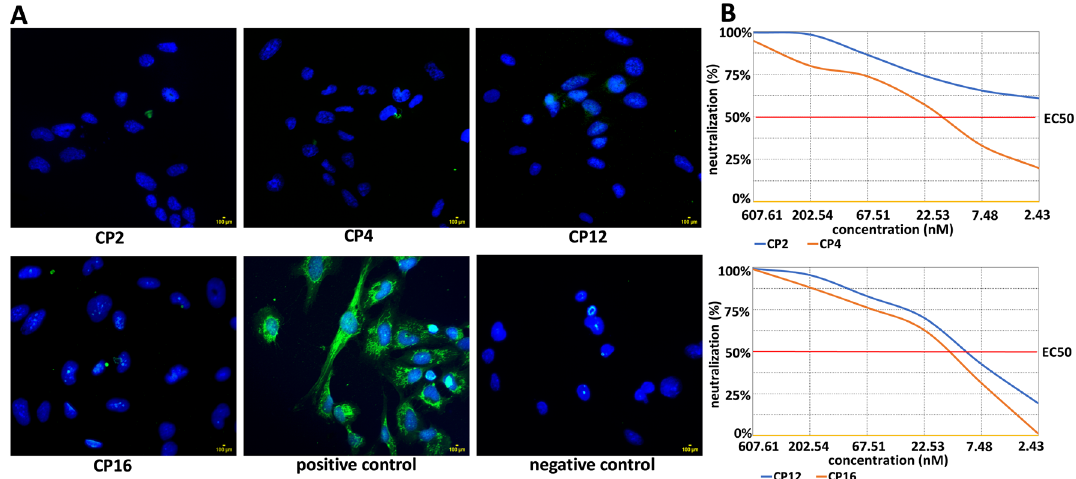
Figure 5. Blocking of the adhesion of rDIII on cultured endothelial cells and neutralization assay. ( A ) Blocking of the adhesion of rDIII on endothelial cells. Nuclei are stained with DAPI. The assay was performed in triplicates. Positive control – rDIII was incubated with the cells. Negative control – rDIII was excluded from the assay. CP – 7-mer cyclic peptide. ( B ) Assessment of the ability of peptide to block infection in cultured cells (neutralization assay). Neutralization of the infection of virus like particle carrying Fluc gene by CP2, CP4, CP12 and CP16. The amount of VLP entering the target cells was calculated by detecting the expression of luciferase, which then used to measure the neutralizing ability of the peptides, expressed in half maximal effective concentration (EC 50 ). Neutralizing capacity of each CP was observed as follows: CP2 – EC 50 > 7290 (17.3 ng/ml, 2.43 nM), CP4 – EC 50 1144 (119.4 ng/ml, 17 nM), CP12 – EC 50 1811 (73.3 ng/ml, 10.4 nM) and CP16 – EC 50 1270 (104.7 ng/ml, 14.8